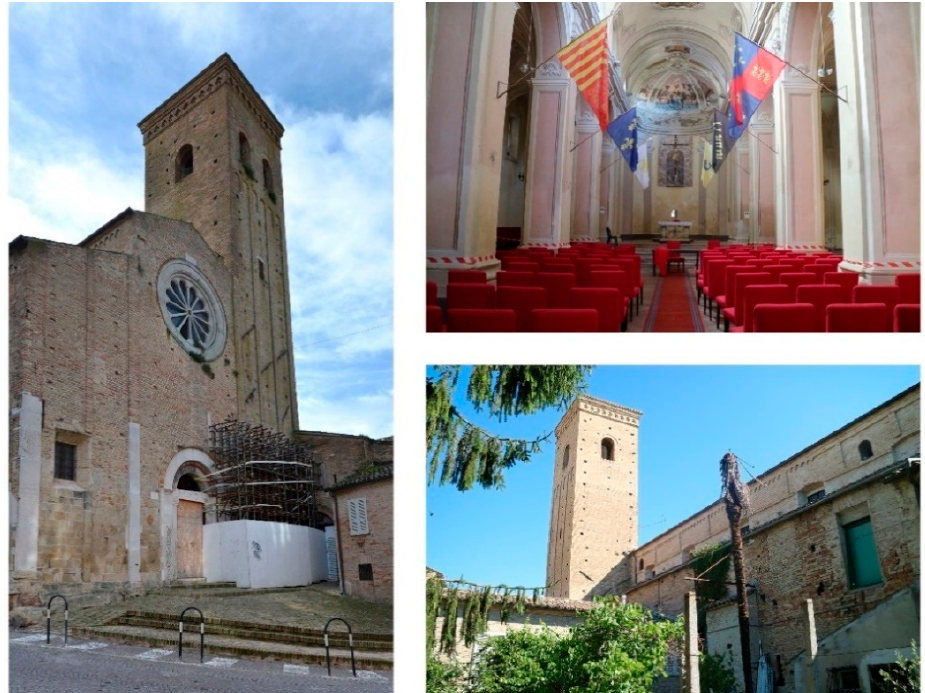
Figure 1. External and internal views of the Church of San Zenone (Fermo, Italy) with its bell tower.